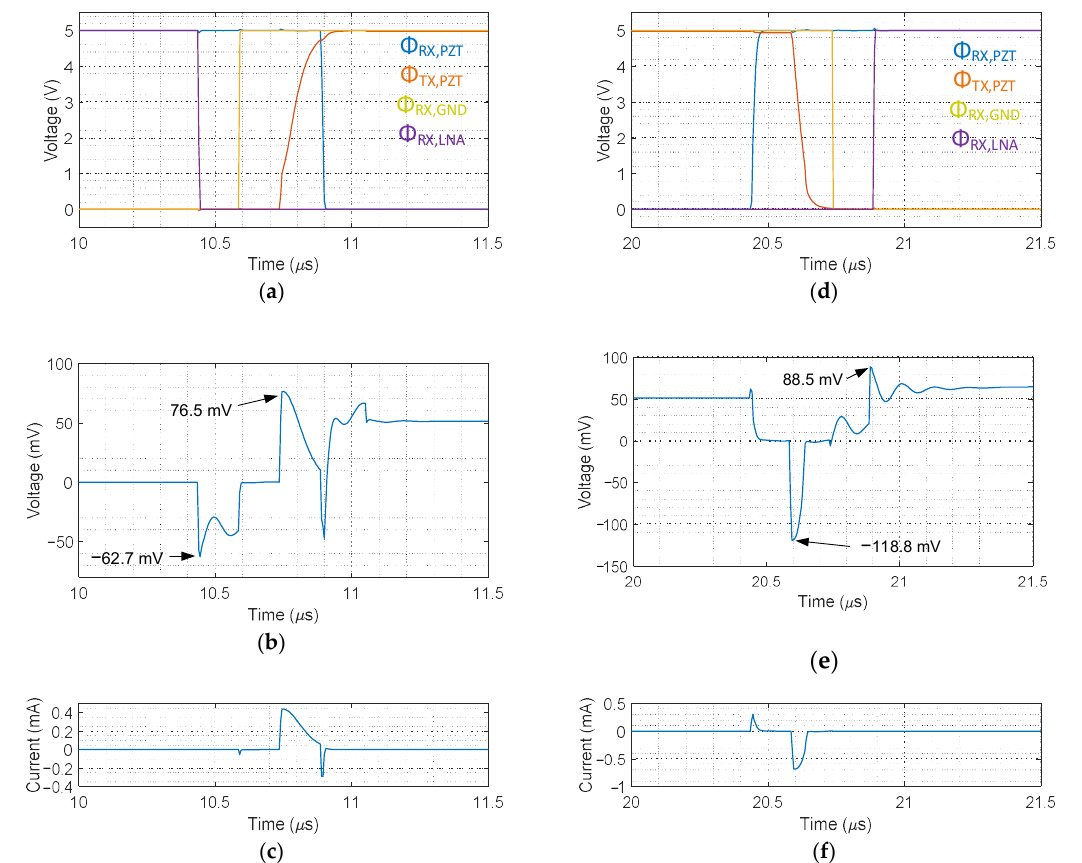
Figure 7. Simulated waveforms with the proposed switch controller at the transition of RX to TX ( a – c ) and vice versa ( d – f ). ( a , d ) Control signals driving the element-level switch circuit, ( b , e ) the switching transients on the transducer element, and ( c , f ) the drain current flowing via